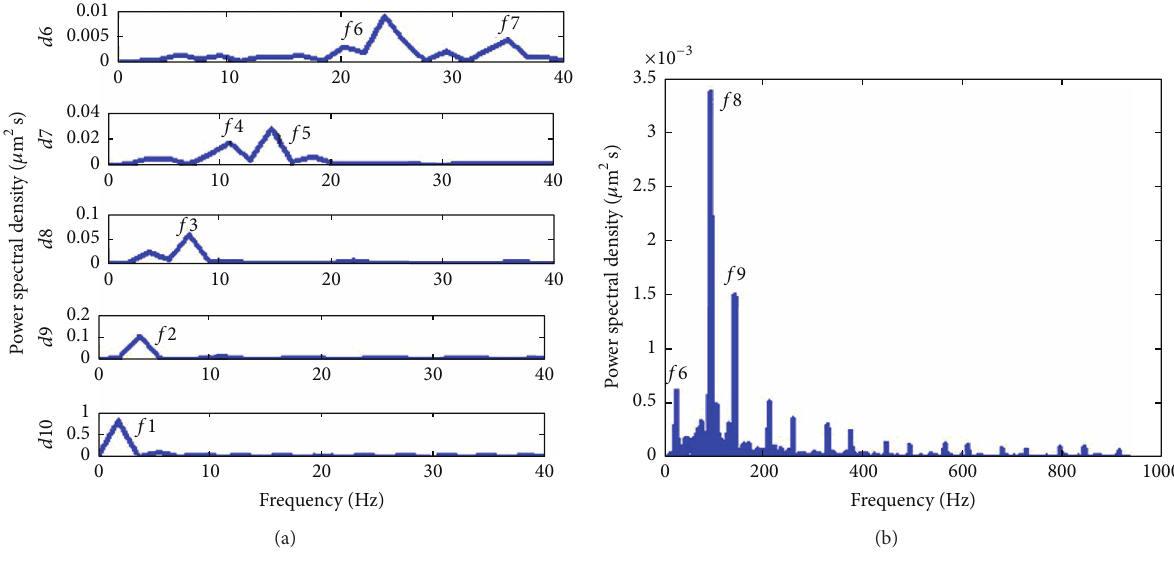
Figure 4: The analyzed result in frequency domain.